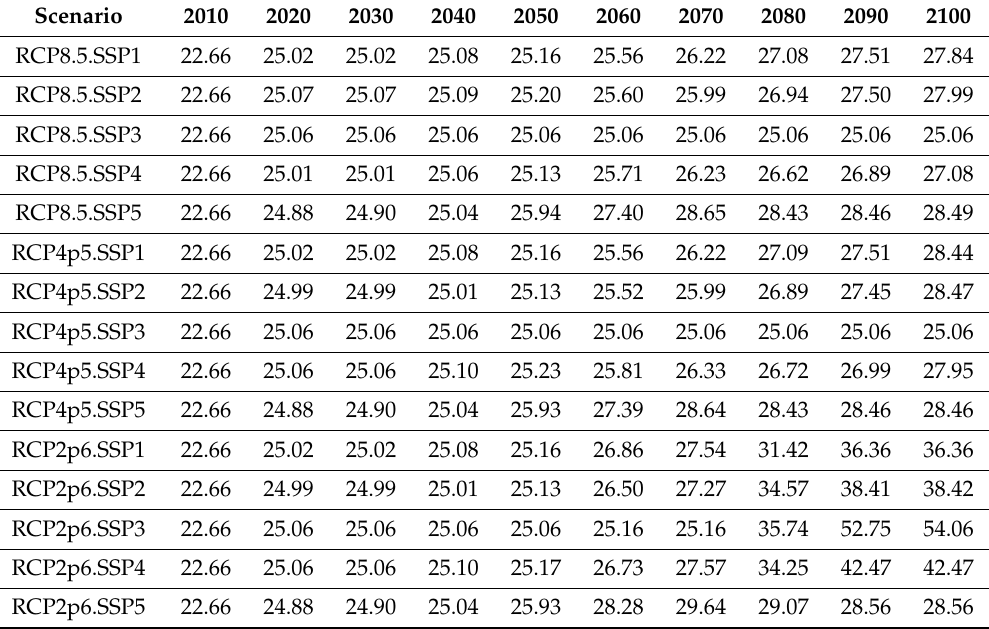
Table A11. Industrial roundwood harvest assortments—Pulpwood (millions of m 3 / year, under bark). Scenario